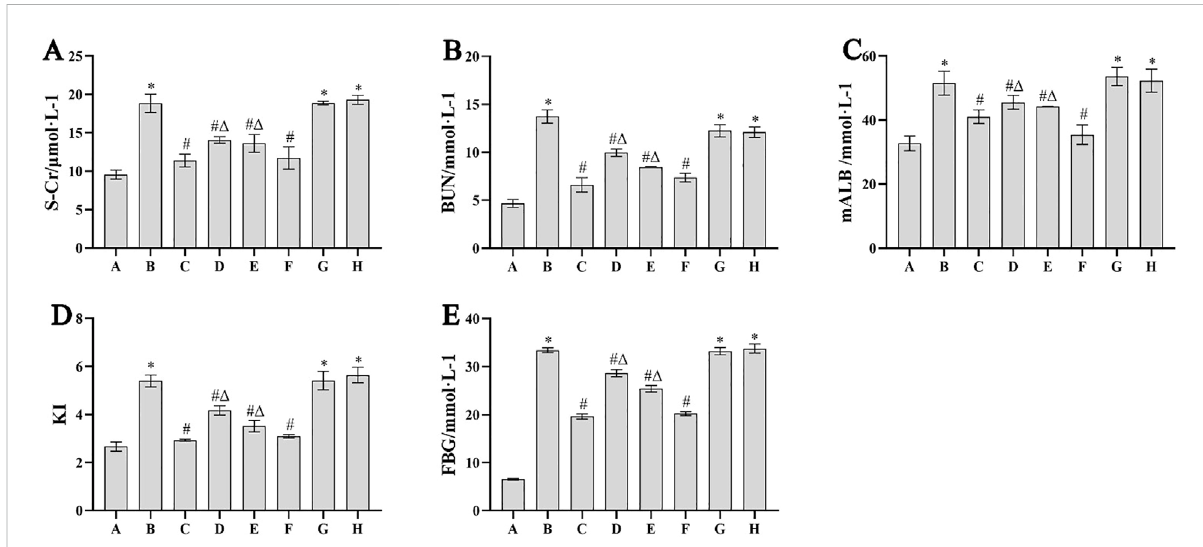
FIGURE 1 Comparison of S-Cr (A) , BUN (B) , mALB (C) , KI (D) and FBG (E) in each group ( n = 10, (cid:1) x ± s ). Note: ① A. Blank group B. DN model group C. Irbesartan group D. Cornus of fi cinalis group E. Wine Cornus of fi cinalis group F. Wine honey Cornus of fi cinalis group G. Auxiliary wine group H. Auxiliarywinehoneygroup. ② Comparedwiththeblankgroup* p < 0.05;comparedwithDNmodelgroup # p < 0.05;comparedwiththewinehoney group Δ P <